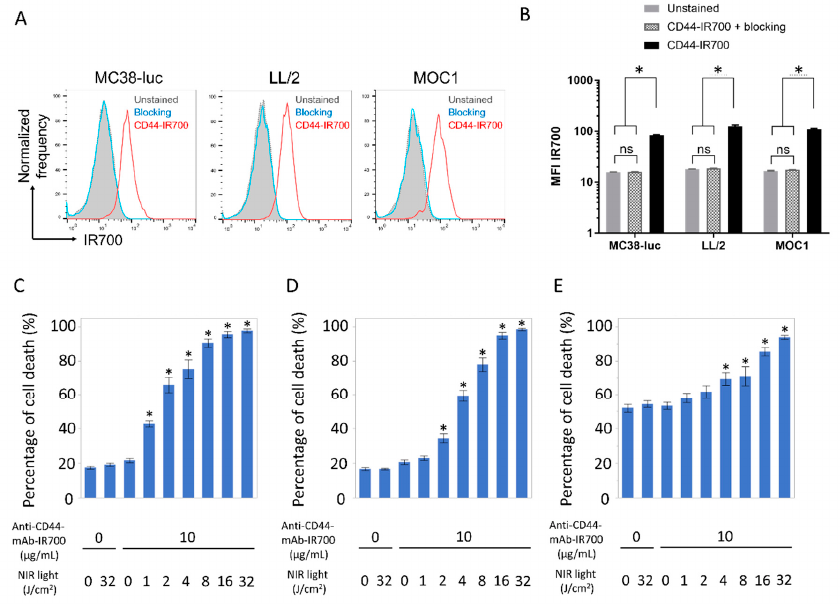
Figure 1. Confirmation of CD44 expression as a target for NIR-PIT and evaluation of in vitro CD44-targeted NIR-PIT in MC38-luc, LL / 2, and MOC1 cells. ( A ) Expression of cell-surface CD44 in MC38-luc, LL / 2 and MOC1 cells was examined with flow cytometry. CD44-blocking antibody